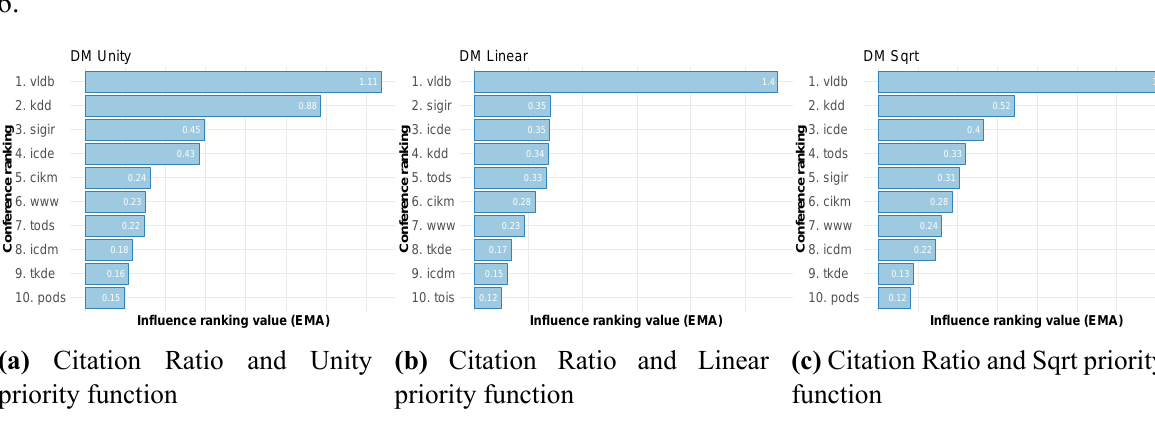
Figure 5. The comparison of top 10 ranking of DM conferences – the result of RI value calculation (Algorithm 3), using Citation Ratio and three different priority functions